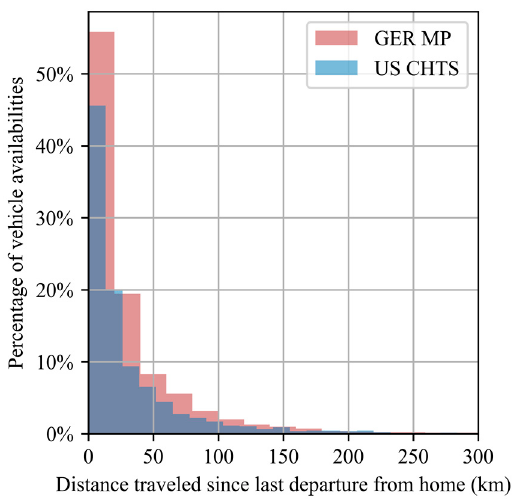
Figure 4. Distribution of the distance traveled since the vehicle’s last departure from home—sampled from all modeled vehicle availabilities.